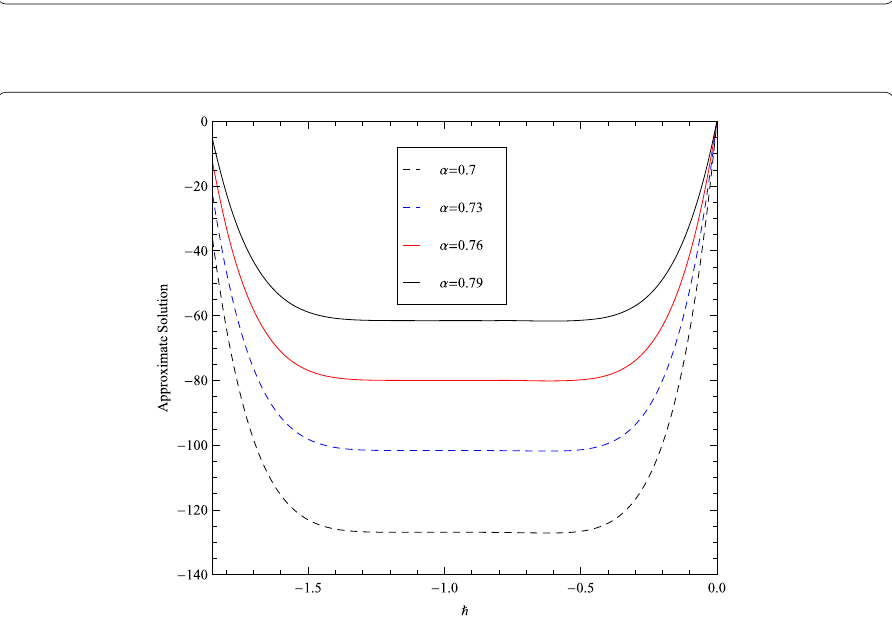
Figure 12 Plot of (cid:2) curve for different values of λ at x = 0.5 and t =